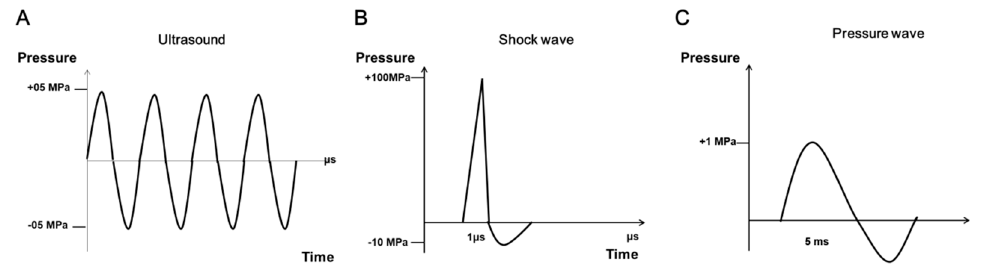
Figure 1. Typical types of ultrasound, focused shock wave, and pressure wave. ( A ) Ultrasound waves are periodic oscillations with a limited bandwidth. ( B ) Focused shock wave is characterized by a single positive pressure wave (100 MPa), followed by a negative pressure wave (-10 MPa). The 1 microsecond ( μ s) of time interval is the positive pressure wave. ( C ) The pressure wave is 1 MPa positive wave and less than 1 MPa negative wave in 5 milliseconds (ms).